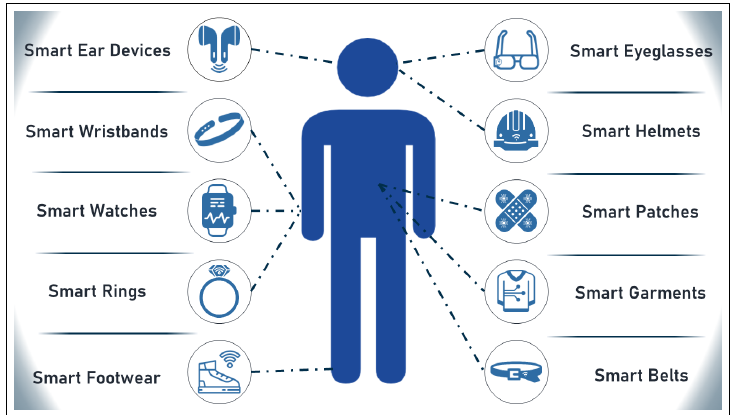
Figure 2. Set of commonly known wearables.